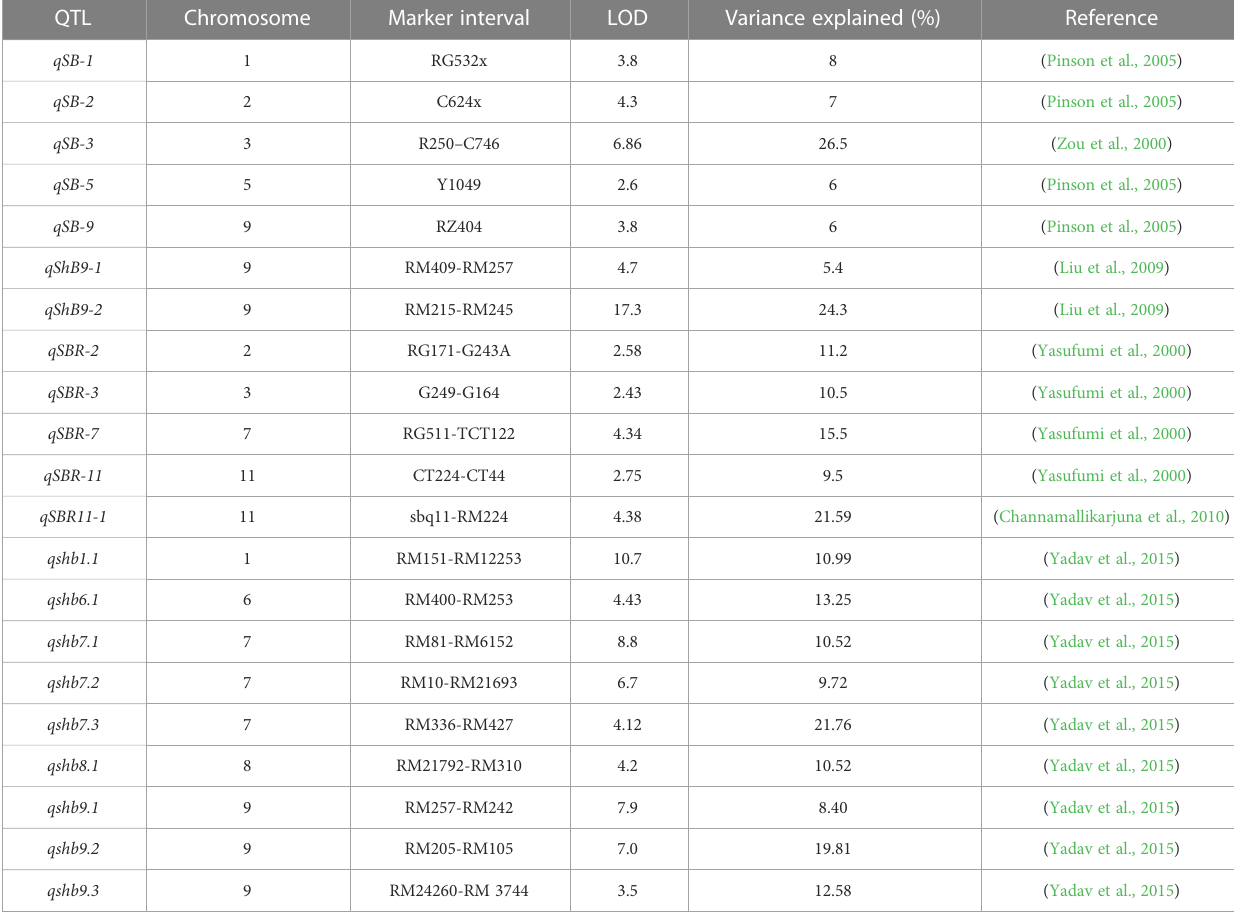
TABLE 1 QTL mapping for ShB resistance in